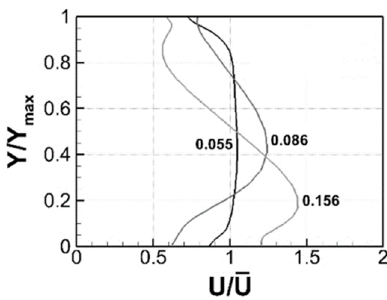
Figure 12. DoE 1 results—Projected 3D criterion space into three individual 2D components ( a – c ).